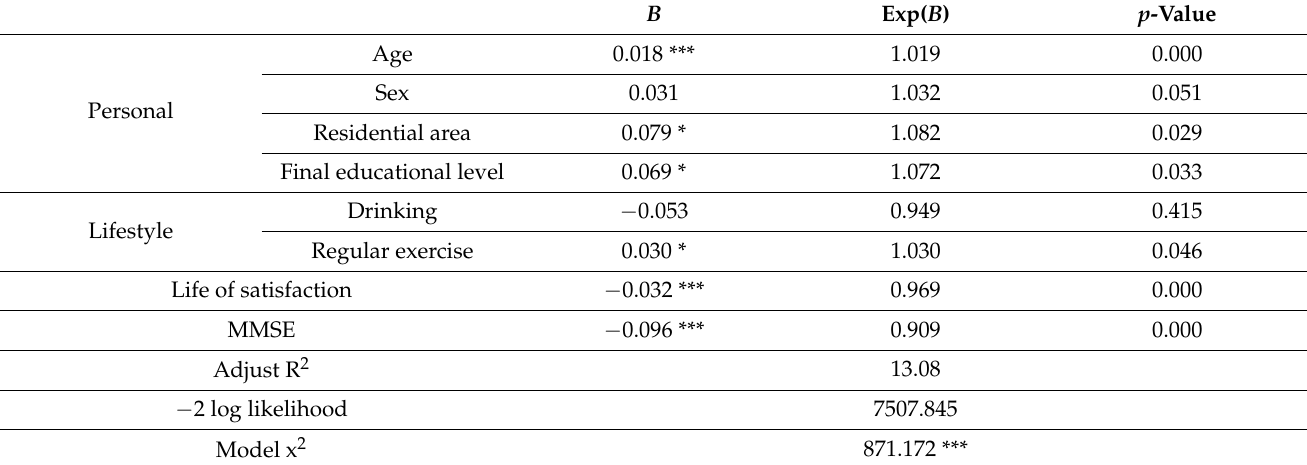
Table 3. Effects of the different factors on